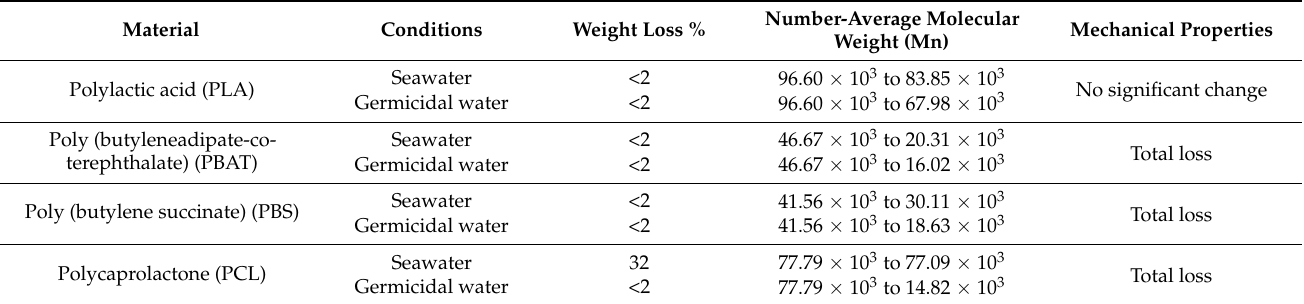
Table 2. Hydrologic degradation of several typical biodegradable polyesters in different water environments. Data from